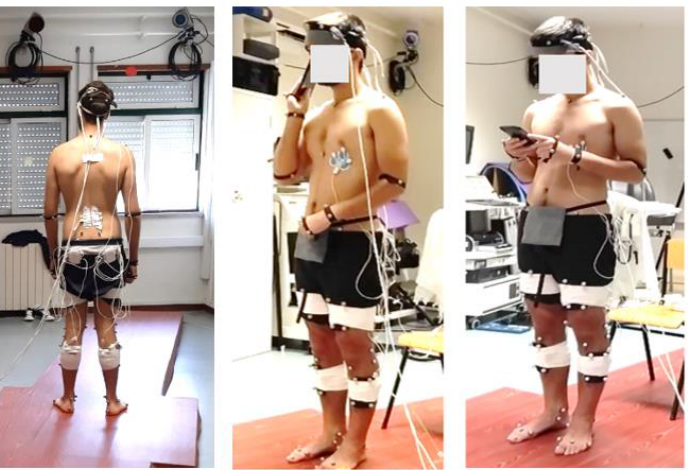
Figure 1. Center-of-pressure time series in the anterior-posterior and mediolateral displacement Figure 1. Center of pressure time series in the anterior-posterior and mediolateral collected from a force plate during the postural single task and the easy and difficult motor dual displacement collected from a force plate during the postural single task and the easy and tasks, respectively, from left to difficult motor dual tasks, respectively, from left to right.